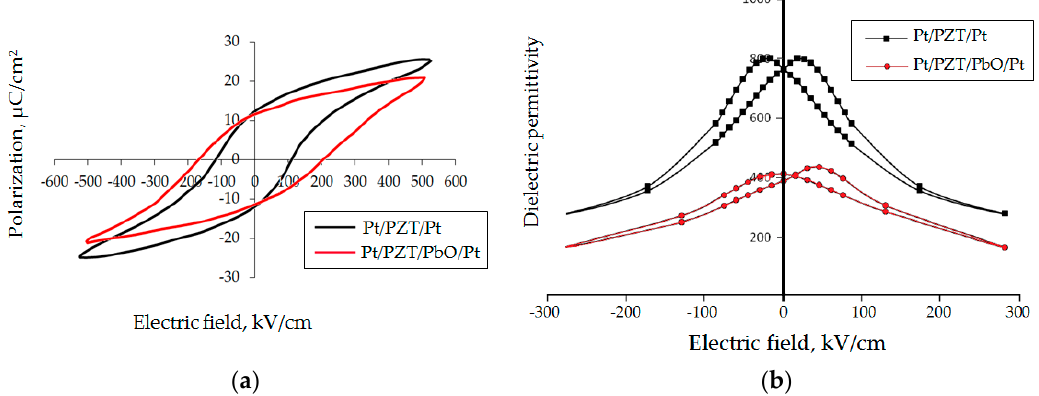
Figure 5. Comparison of the characteristics of PZT films with and without a PbO sublayer: ( a ) Hysteresis loops; ( b ) The dependences of the reversible dielectric permittivity on the electric field. The thickness of PZT film was 400 nm.